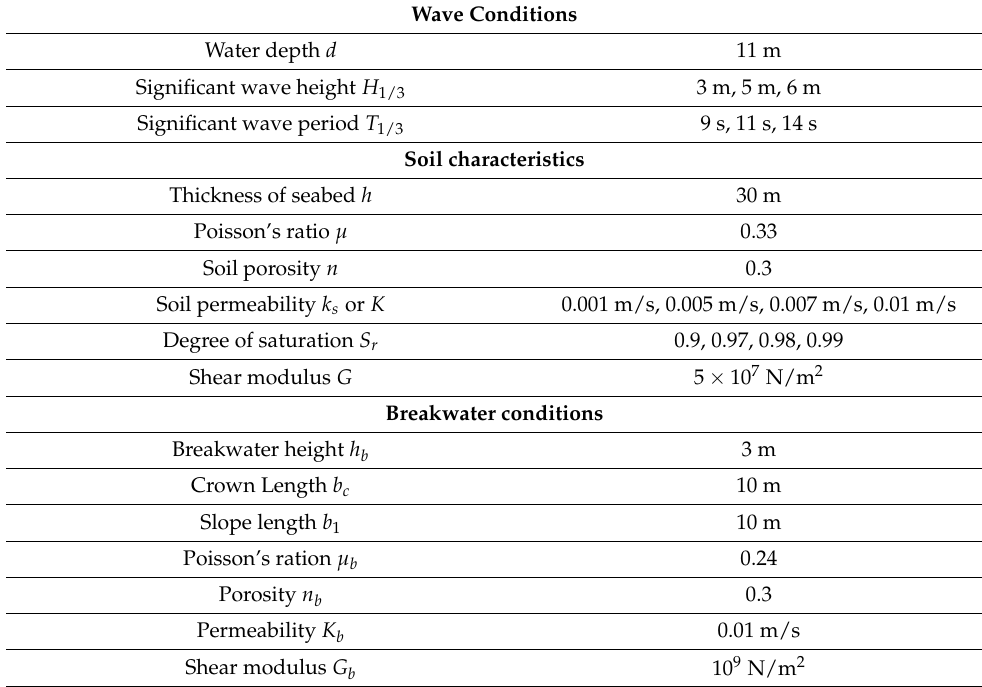
Table 3. Input data for the irregular wave-induced soil response around the